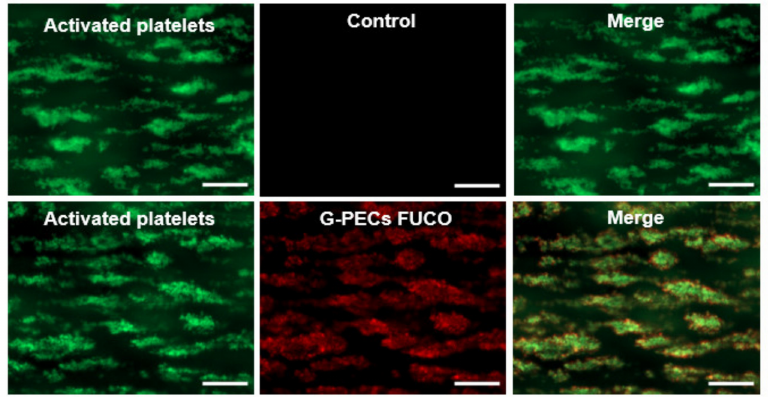
Figure 2. P-selecting targeting polysaccharide-based nanogels (G-PECs fuco) for specific miRNA delivery in atherothrombotic-related diseases. Particles and platelets aggregates co-localization was evaluated by merged fluorescence microscopy images (right). G-PECs without fucoidan were used as control. Scale bars corresponds to 50 µ m. Reproduced with permission from Elsevier [127]. After internalization by targeted cells, carriers need also to deal with nucleic acid